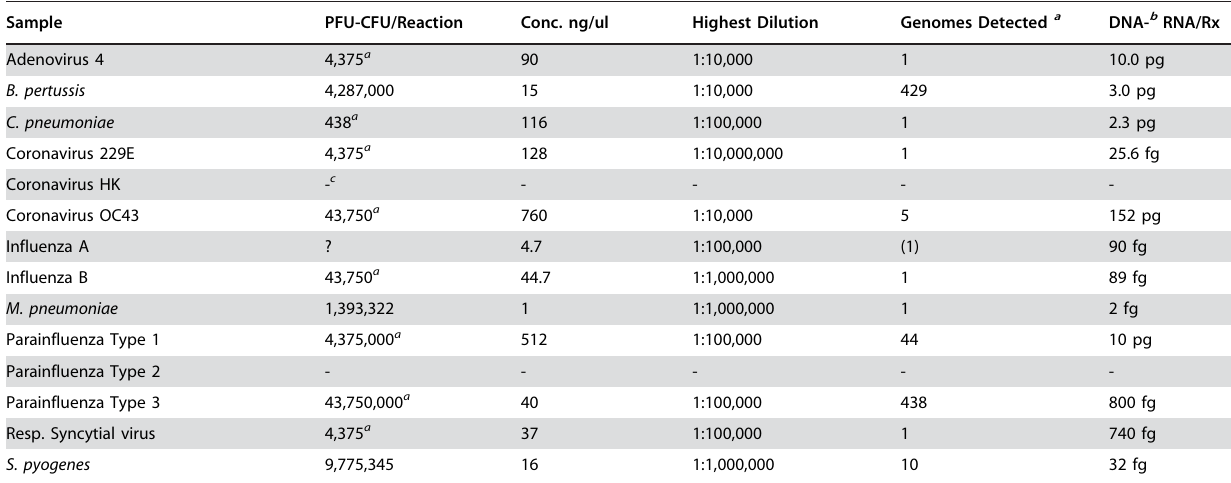
Table 2. Assay sensitivity tests for viral and bacterial URI pathogens. .. ... .... ... ... .... ... ... .... ... ... .... ... ... .... ... ... .... ... ... .... ... ... .... ... ... .... ... ... .... ... ... .... ... ... .... ... ... .... ... ... .... ... ...